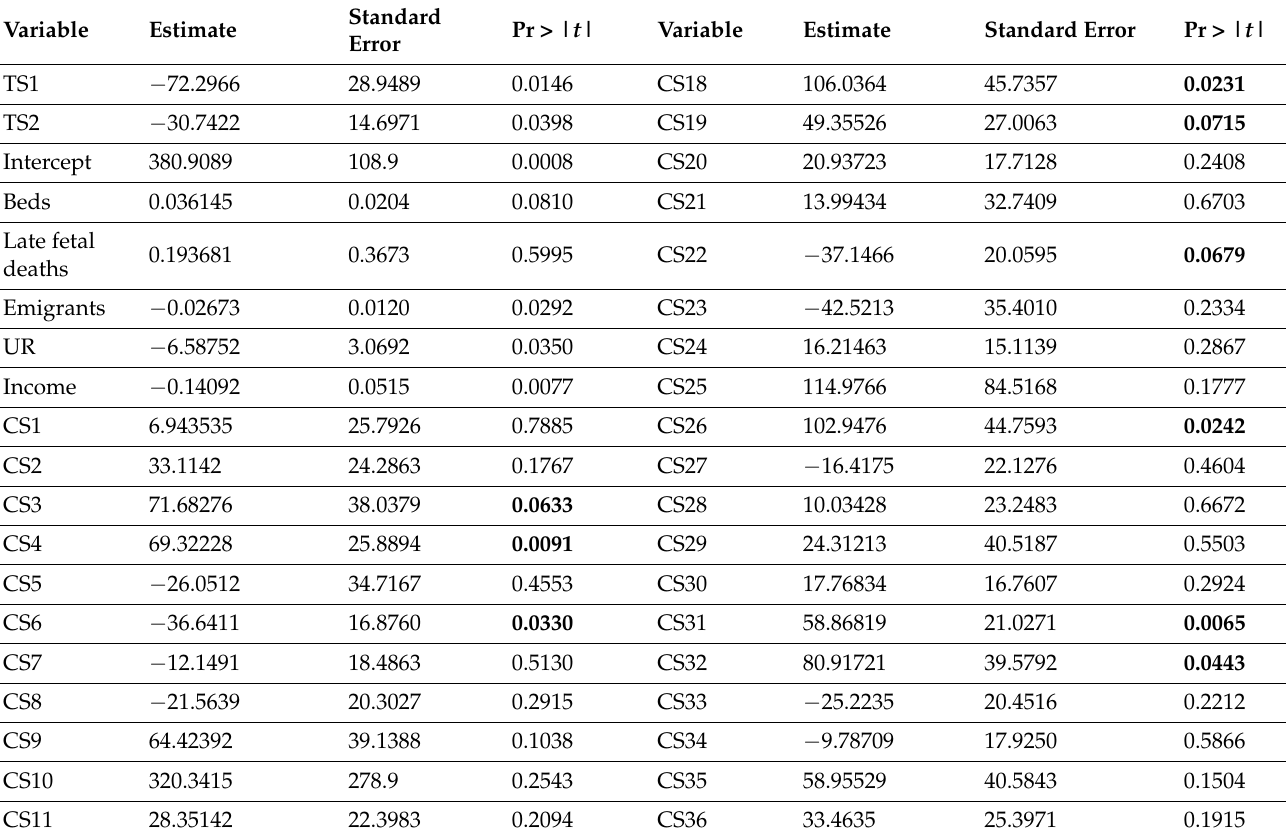
Table 5. Estimation of the regression model